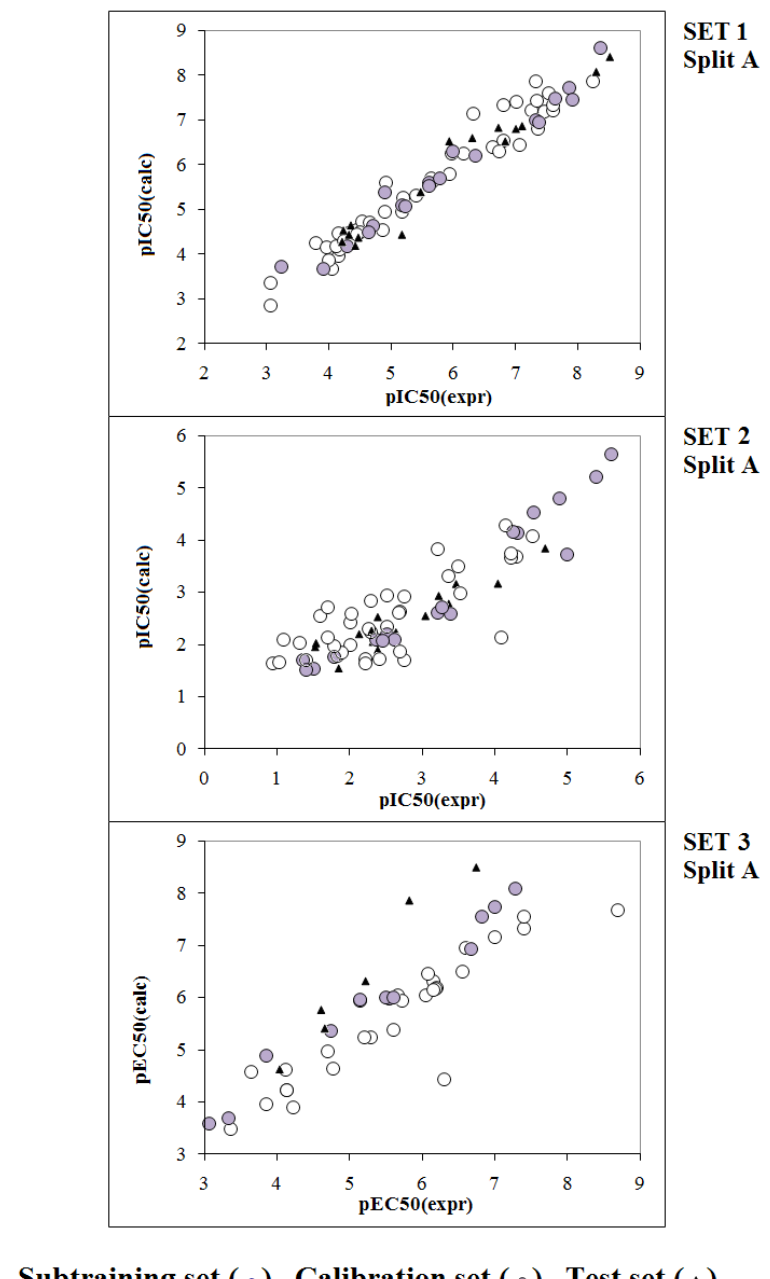
Figure 2. QSAR models for anti-HIV-1 activity (pIC (pEC ) for fullerene C60 derivatives for SET 3 (Split 50